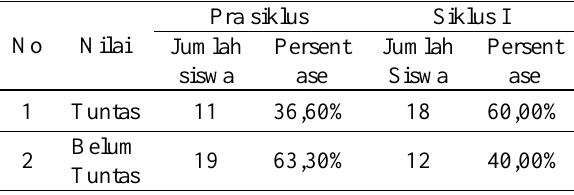
Tabel 4. Distribusi Frekuensi Nilai Mata Pelajaran